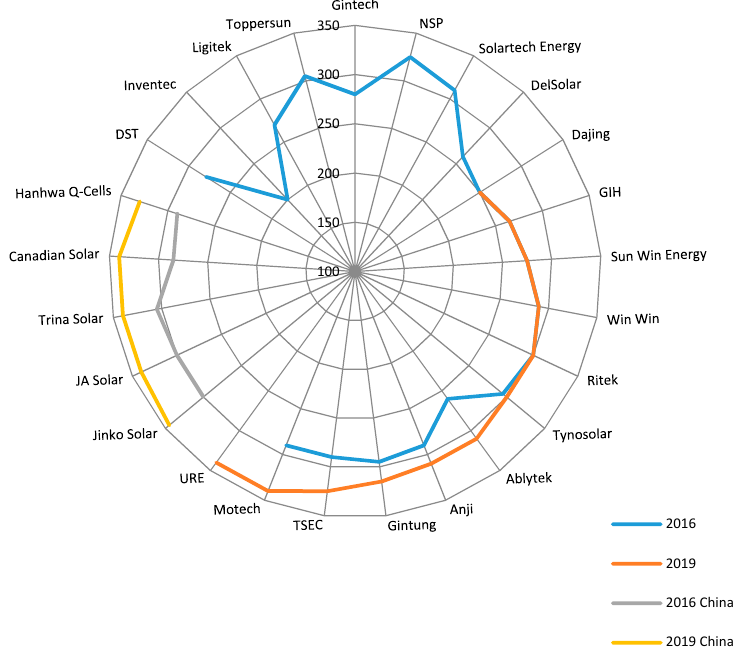
Figure 13. c-Si mono module power (Wp) of Taiwanese manufacturers within the period.